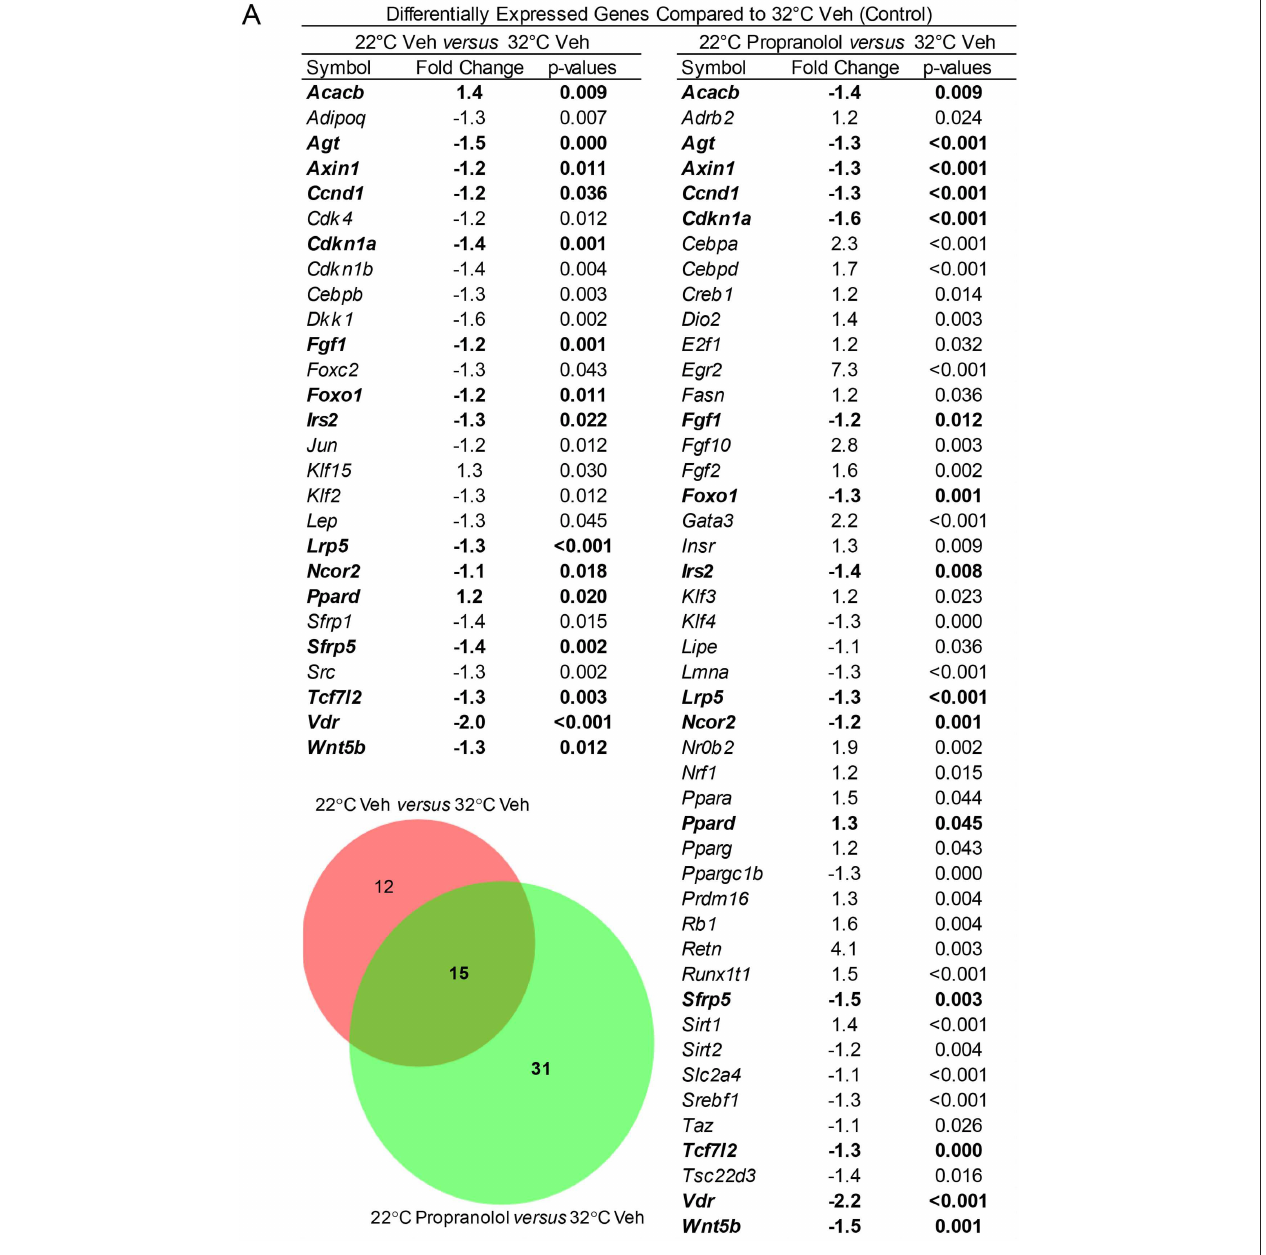
FIGURE 6 | Effect of housing temperature and treatment with propranolol on expression of adipogenesis-associated genes (adipogenesis PCR array) in whole tibia. The Venn diagram shows the number of differentially expressed genes unique to temperature (22 ◦ C Veh vs. 32 ◦ C Veh, n = 12), number of differentially expressed genes unique to propranolol (22 ◦ C Propranolol vs. 32 ◦ C Veh, n = 31) and number shared by temperature and propranolol ( n = 15). The gene list for differentially expressed genes is shown in the accompanying Table. Shared genes are